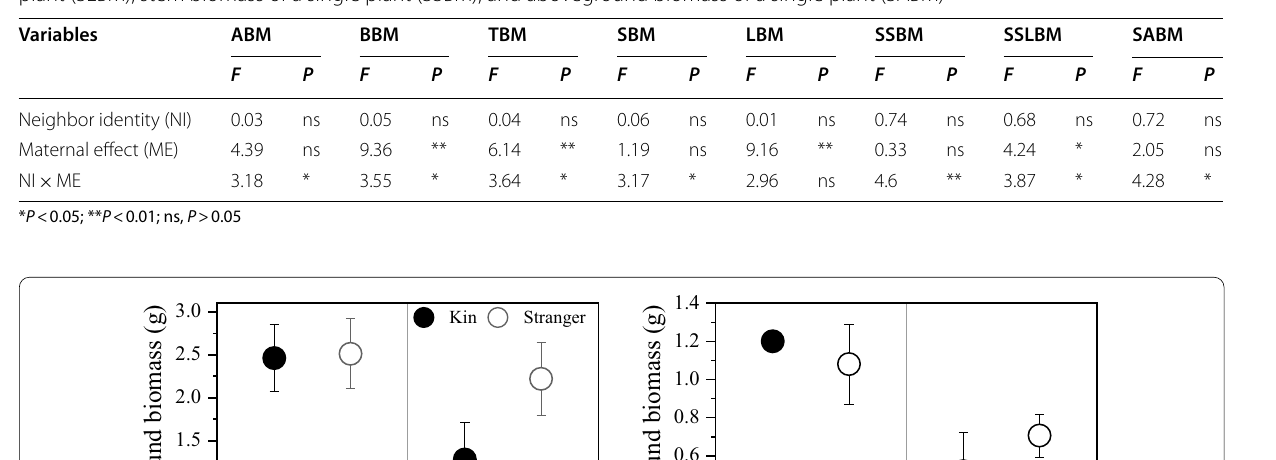
, offspring of long-term overgrazed L. +